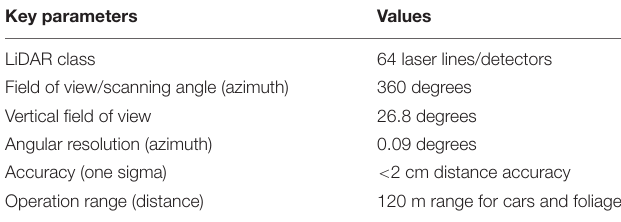
TABLE 1 | Key parameters of Velodyne HDL64E-S3.